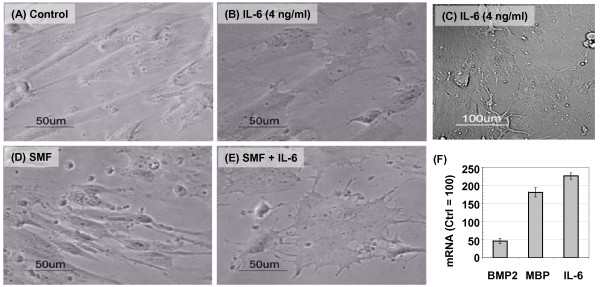
Morphological effects of SMF and IL-6 on hEBD LVEC cells. (A) Phase contrast images showing the normal morphology of ~90% confluent hEBD LVEC cells. (B) Slightly altered morphology typically was seen after incubating the cells with 4.0 ng/ml of IL-6 for 3 days. (C) Cells incubated with 4.0 ng/ml IL-6 sporadically attained dramatically altered cell morphology, with neurite-like outgrowths. (D) SMF, by itself, had a minor impact on the morphology of hEBD LVEC cells. (E) The combination of SMF and 4.0 ng/ml IL-6 resulted in ~100% of the cells attaining the distinctively altered morphology shown. (F) mRNA levels of bone morphogenetic protein 2 (BMP2), myelin basic protein (MBP), and IL-6 after 24 h of SMF exposure (error bars represent SD for n ≥ 3 independent experiments and p < 0.05 for each marker).